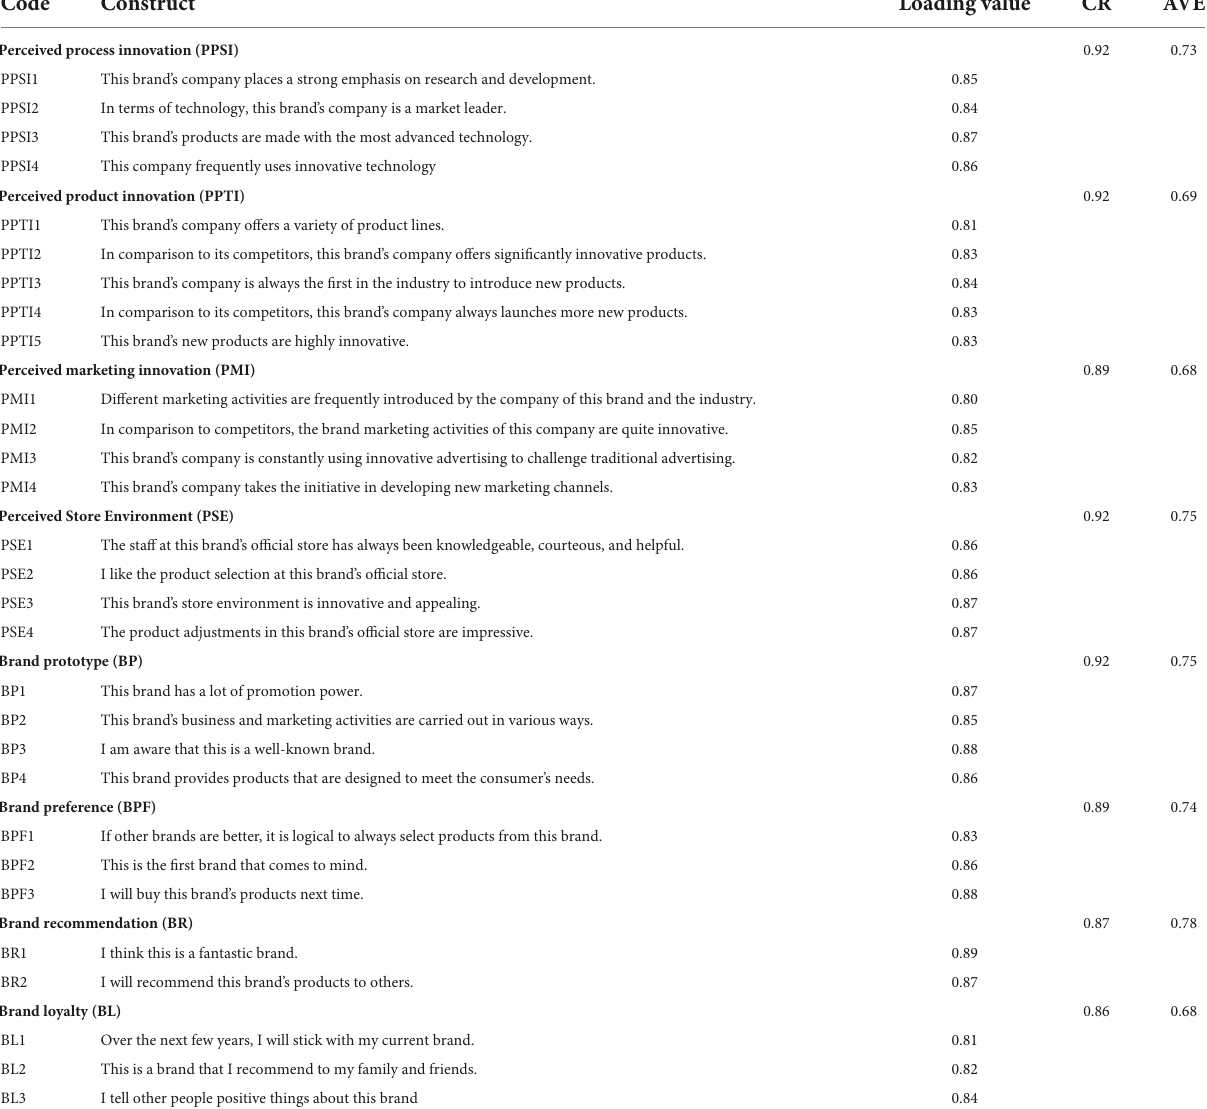
TABLE 3 Constructs loading, composite reliability (CR), and average variance extracted